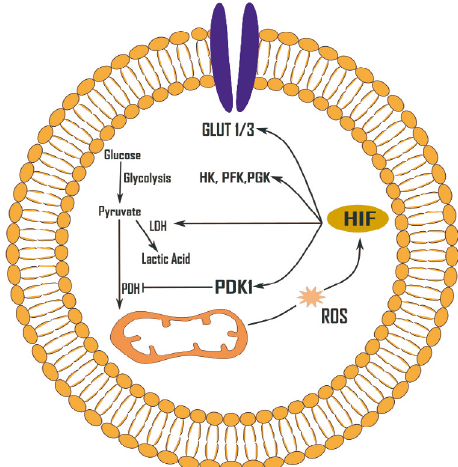
O ) on glycolysis up-regulation mediated by HIF-1. HIF-1 can be activated by a variety of ROS. GLUT Figure 4. Effects of ROS (H 2 2 1/3: glucose transporter 1/3; HK: hexokinase; LDH: lactate dehydrogenase; PDH: pyruvate dehydrogenase; PDK1: pyruvate dehydrogenase kinase 1; PFK: phosphofructokinase; PGK: phosphoglycerate